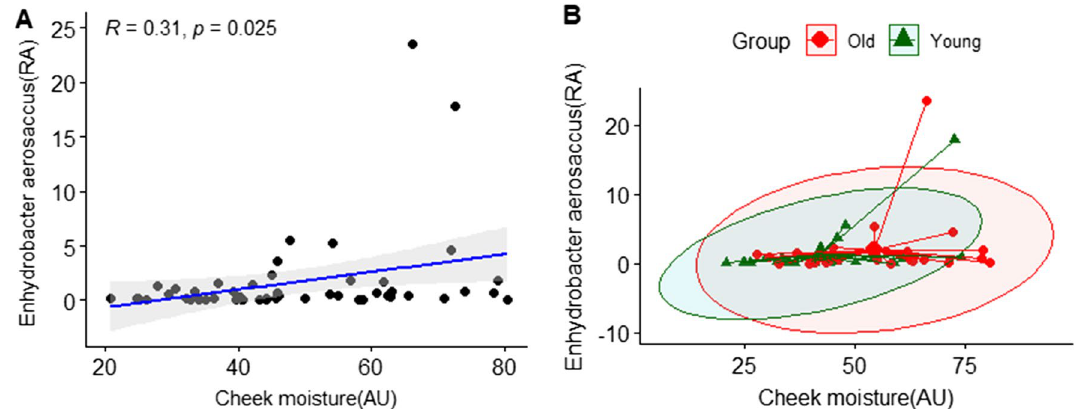
Figure 10. Correlation analysis between the relative abundance (%) of Enhydrobacter aerosaccus and clinical skin parameters. ( A ) Pearson correlation between the relative abundance (%) of Enhydrobacter aerosaccus and cheek moisture (AU); ( B ) age-related Pearson correlation between the relative abundance (%) of Enhydrobacter aerosaccus and cheek moisture (AU). The green color indicates the younger group, and the red color indicates the older